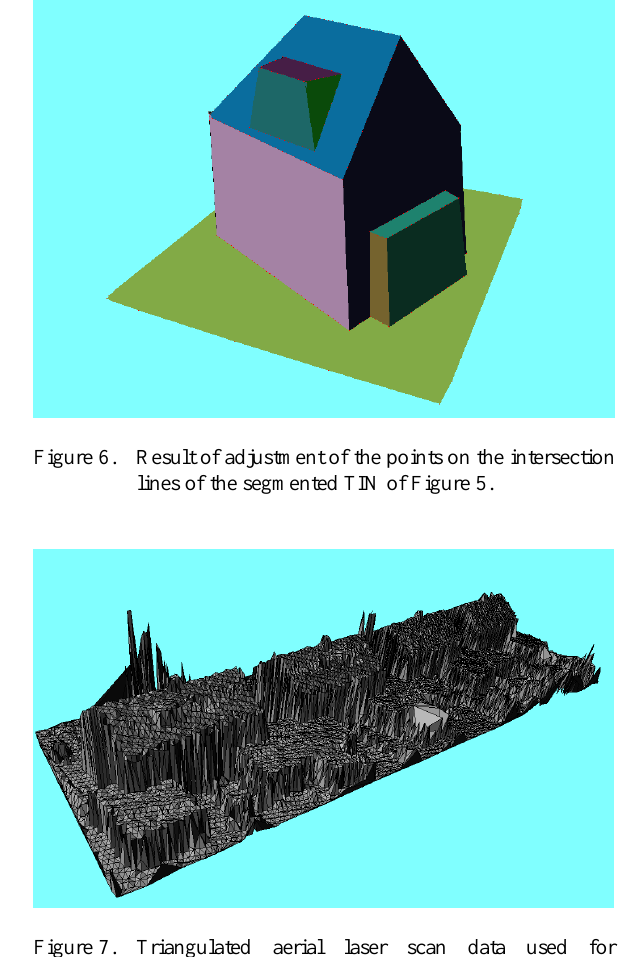
Figure 7. Triangulated aerial laser scan data used for evaluating the